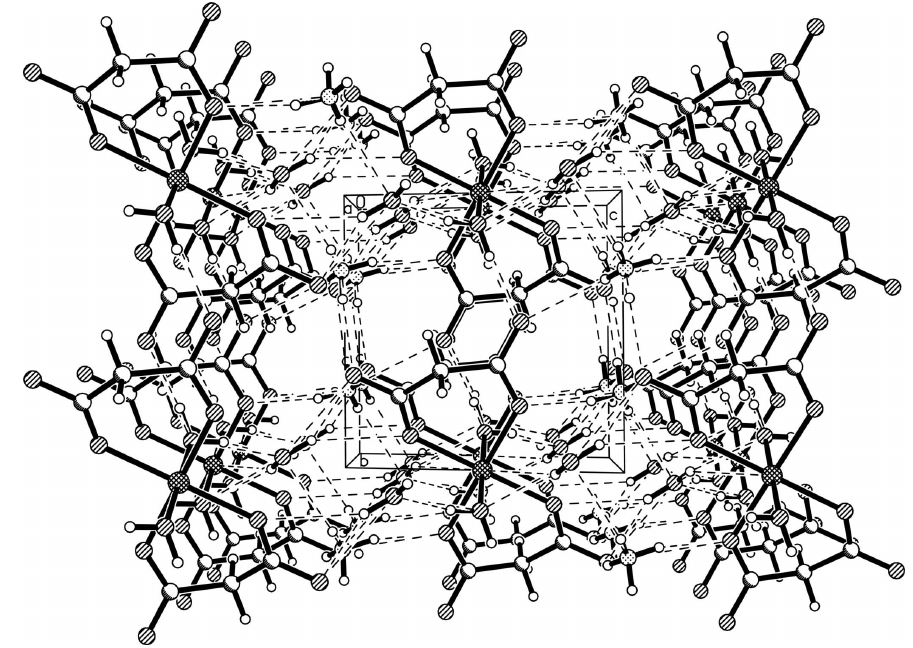
Figure 2 The 3-D superamolecular structure of (I). Hydrogen bond interactions are shown as dashed lines. Diammonium diaquabis(malonato- κ 2 O , O ′ )cobalt(II) dihydrate Crystal